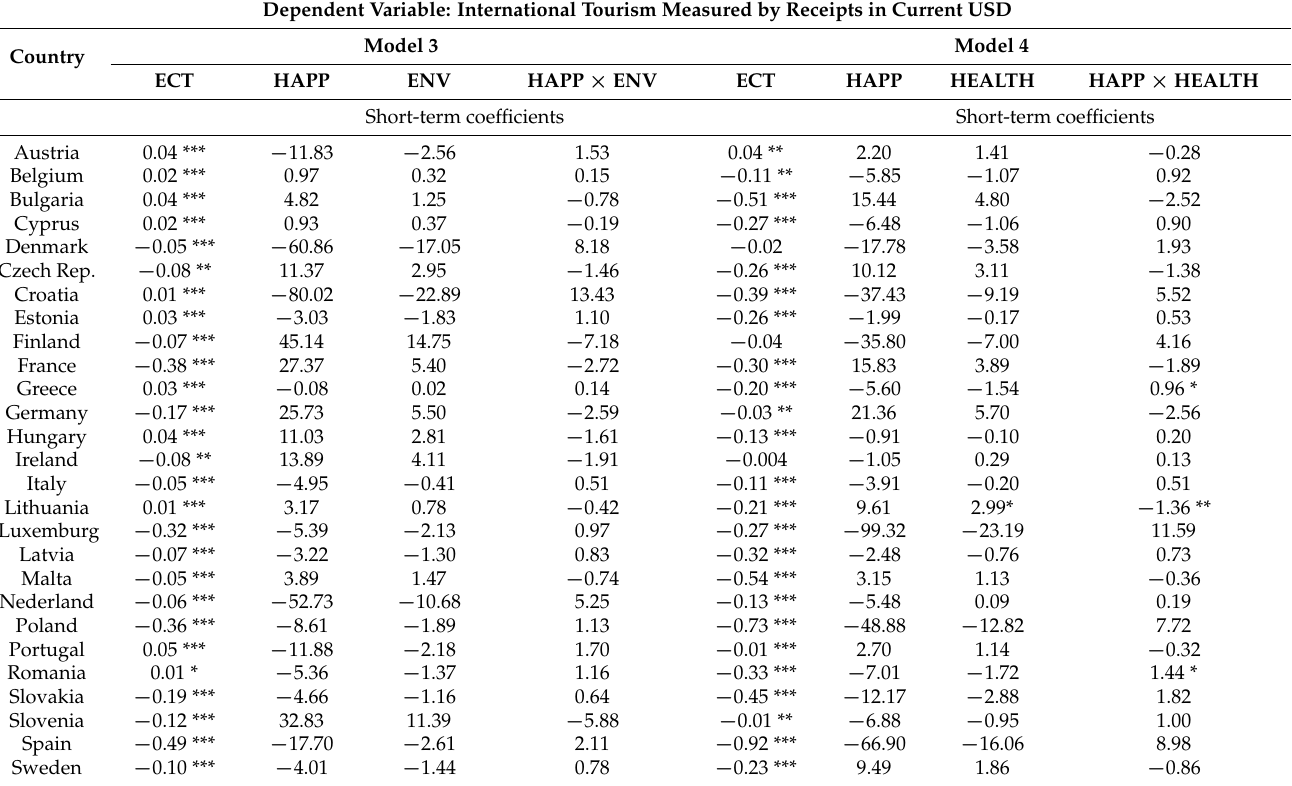
Table A2. Cross-section short-term coefficients. REC—dependent